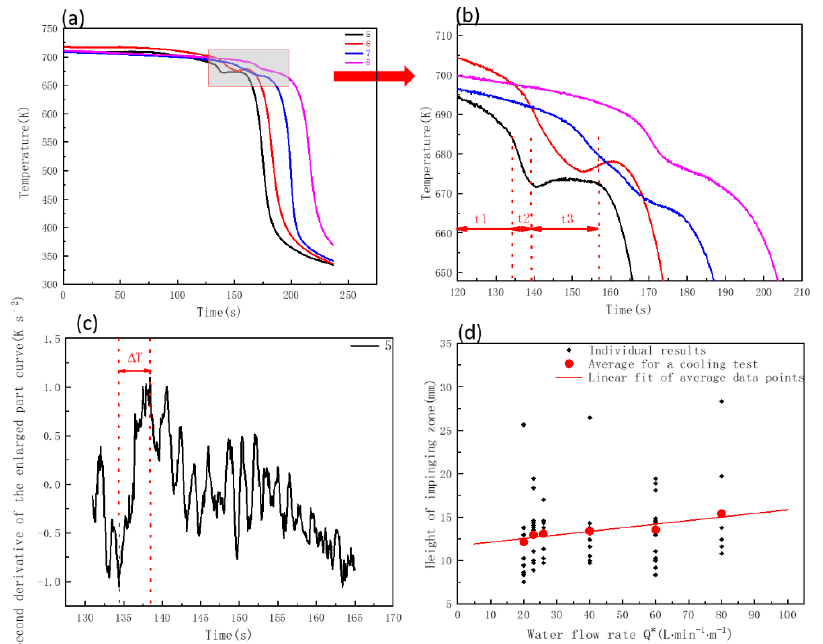
Figure 9. Typical measured cooling curves for IZ height test: ( a ) temperature decrease curve during the IZ height measurement test; ( b ) the enlarged zone marked in ( a ); ( c ) second derivative of temperature d2/dt2 measured during IZ height measurement; ( d ) impingement zone height Hi as function of water flow rate 𝑄 ∗ .